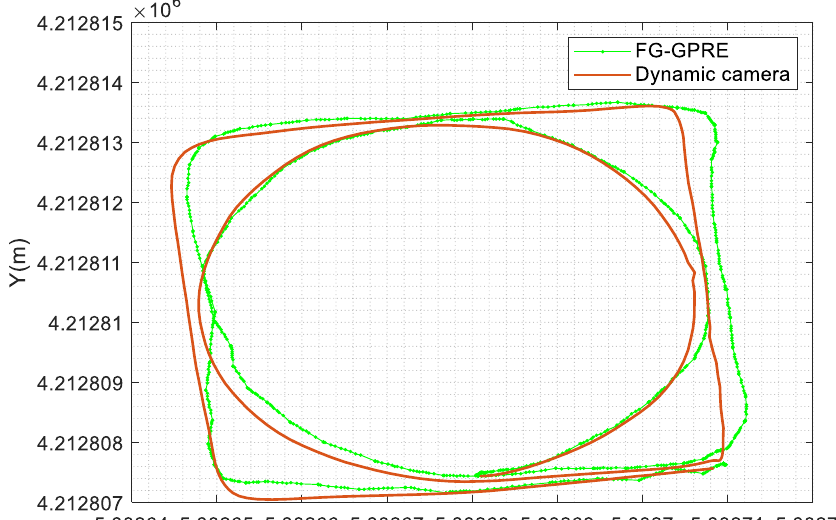
Figure 7. The first group of positioning accuracy comparison test. Table 3. Locate the performance profiling